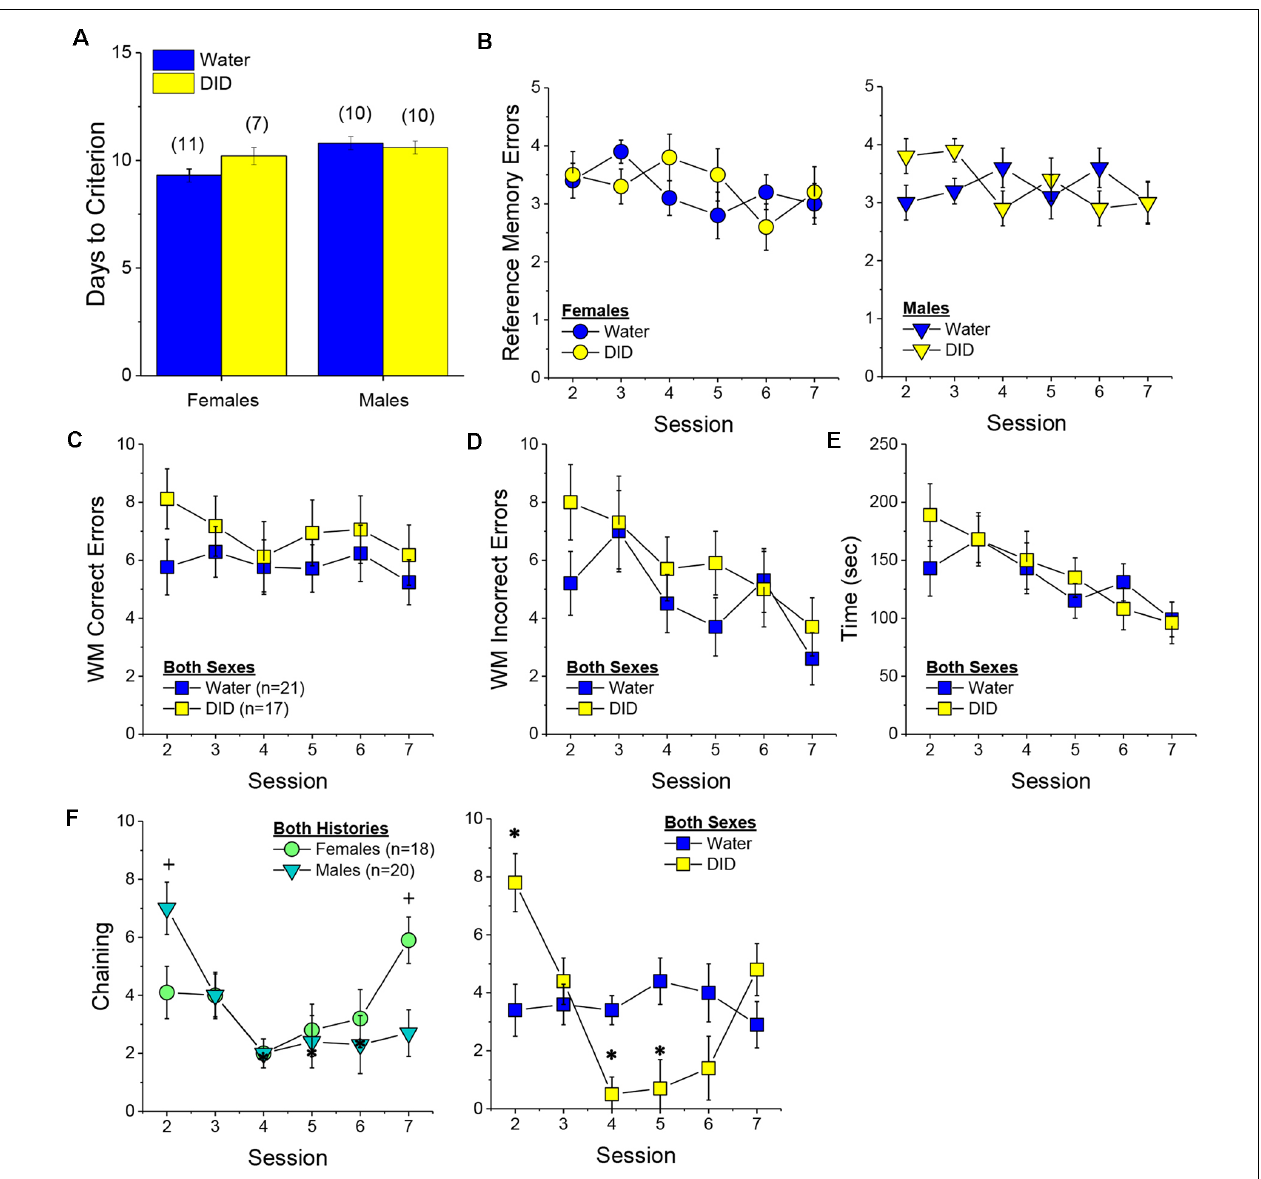
FIGURE 4 | Effects of binge drinking during later maturity (6–9 months of age) on radial arm maze performance in a heterogeneous cohort of mice. No effects of binge drinking (DID) were detected for the number of training days required to reach asymptotic performance in the radial arm maze (A) , the number of reference memory errors (B) , working memory (WM) correct errors (C) , WM memory incorrect errors (D) or the time taken (E) to navigate the radial arm maze over the first week of training. (F) Group differences were detected in the time-course of chaining behavior in Experiment 1; chaining decreased and increased linearly with training in males and females, respectively (left) , while chaining was stable in Water controls, it exhibited a U-shaped time-course in DID mice (right) . The data represent the means ± SEMs, adjusted for the covariates of age and background, of the number of mice indicated in parentheses. ∗ p < 0.05 Water vs DID; + p < 0.05 Male vs. Female (sex difference).